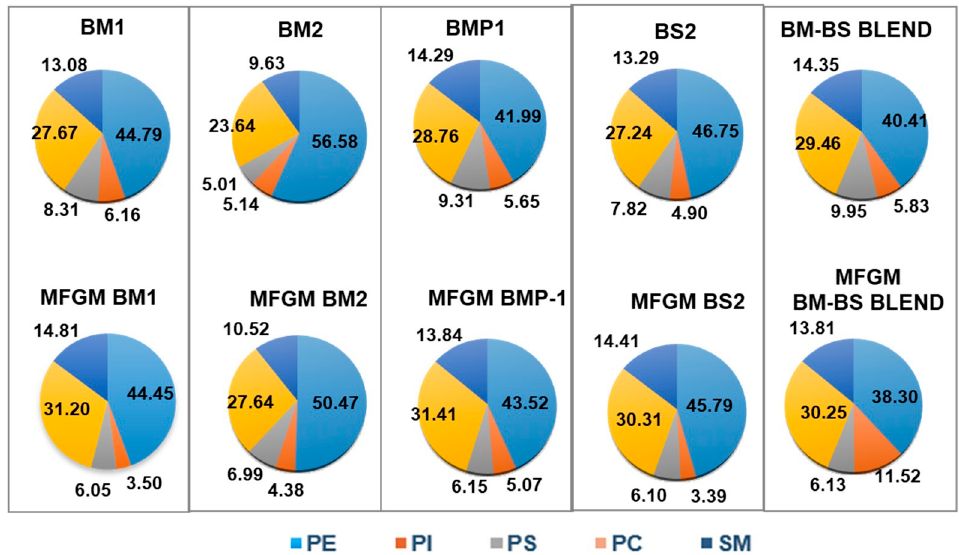
Figure 4. Distribution of phospholipids and sphingomyelin (mean values expressed as % of PL) of the selected samples and their corresponding MFGM isolates. PE: phosphatidylethanolamine, PC: phosphatidylcholine, PS: phoshatidylserine, PI: phosphatidylinositol, and SM: sphingomyelin of the buttermilk (BM) and butterserum (BS) and their corresponding MFGM isolates.